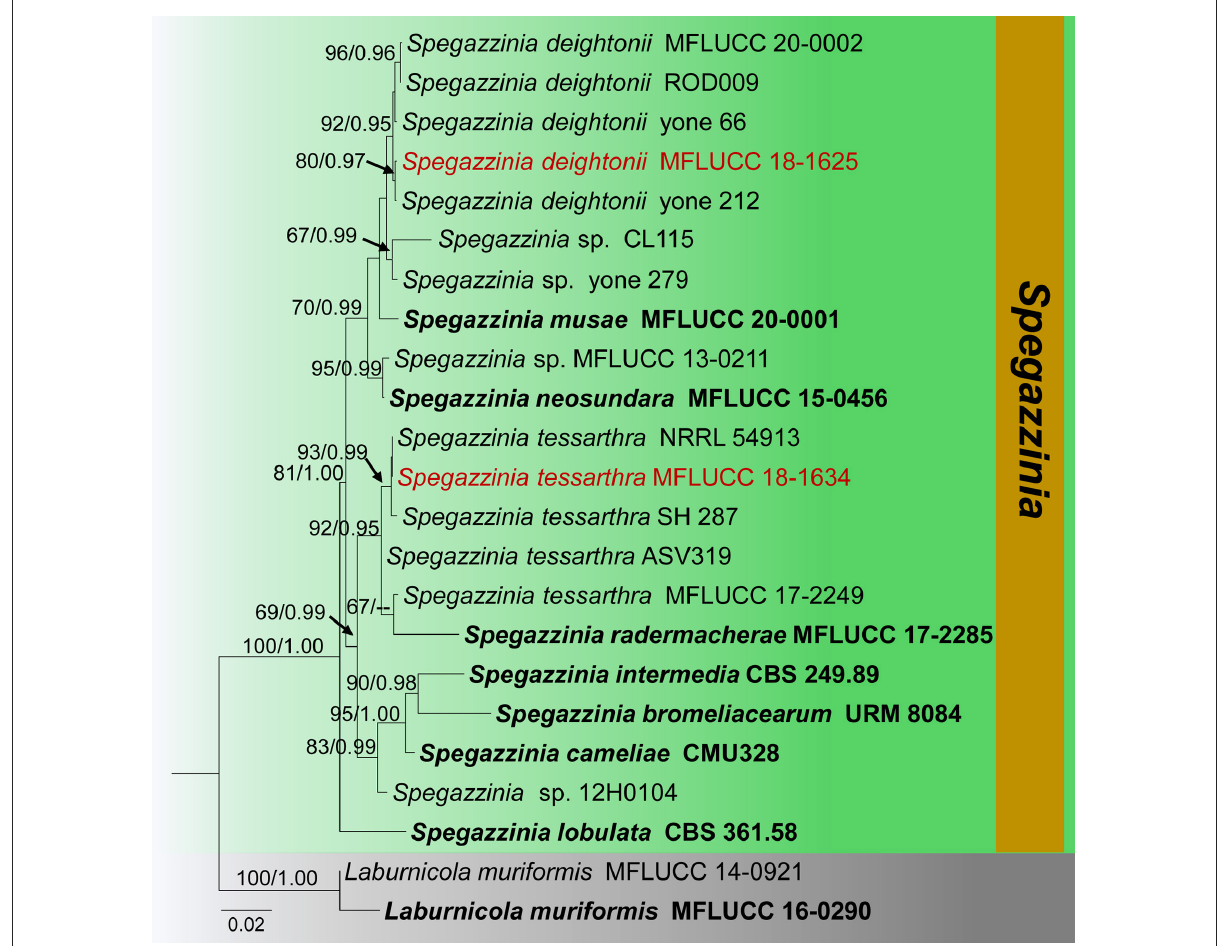
FIGURE11 Phylogram generated from maximum likelihood analysis is based on combined ITS, LSU, SSU, and tef1- α sequence data (Final likelihood value of − 8278.609544). The tree is rooted with Laburnicola muriformis (MFLUCC 14-0921, MFLUCC 16-0290). The ex-type strains are indicated in bold, and the new strains are indicated in red. Bootstrap support values ≥ 65% of maximum likelihood (ML) and Bayesian posterior probabilities (PP) values ≥ 0.90 are given above the